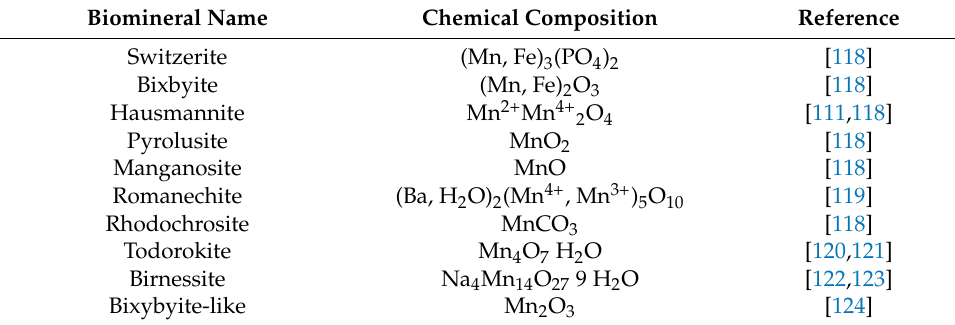
Table 1. Diversity of biogenic manganese oxides. Biomineral